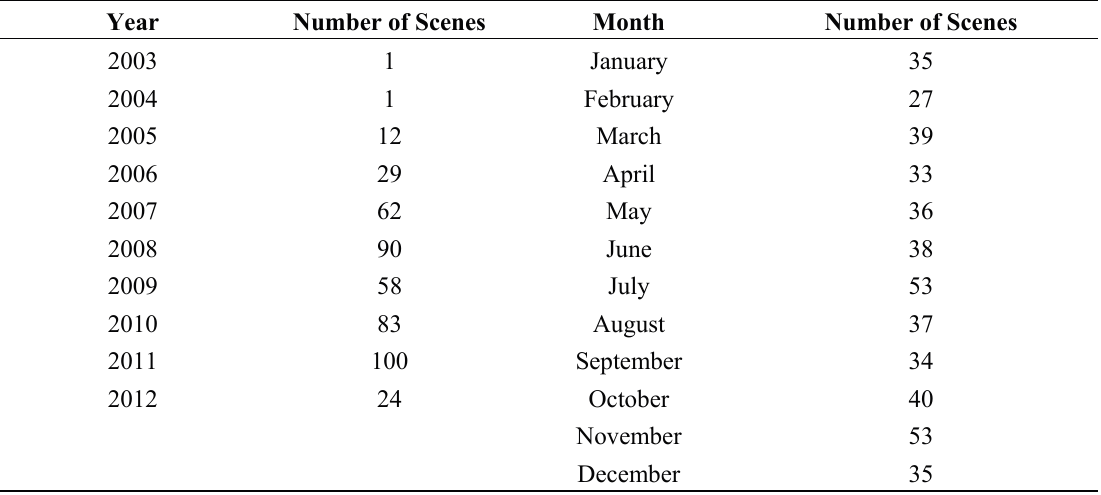
Table 1. SAR data used in the study per year and per